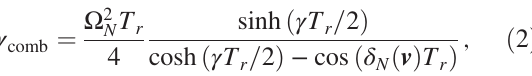
FIG. 1. Constructive interference of multiple paths in a two- photon transition driven by a transform-limited optical frequency comb. All pairs of comb teeth whose sum frequency matches the excited state energy interfere constructively to excite atoms. Two example pairs are shown as (a) and (b), and the effective two-level system that results from the sum is shown in (c). Every tooth of the resulting “ two-photon comb ” of resonant coupling strength Ω leverages the full power of all of the optical frequency comb teeth through this massively-parallel constructive